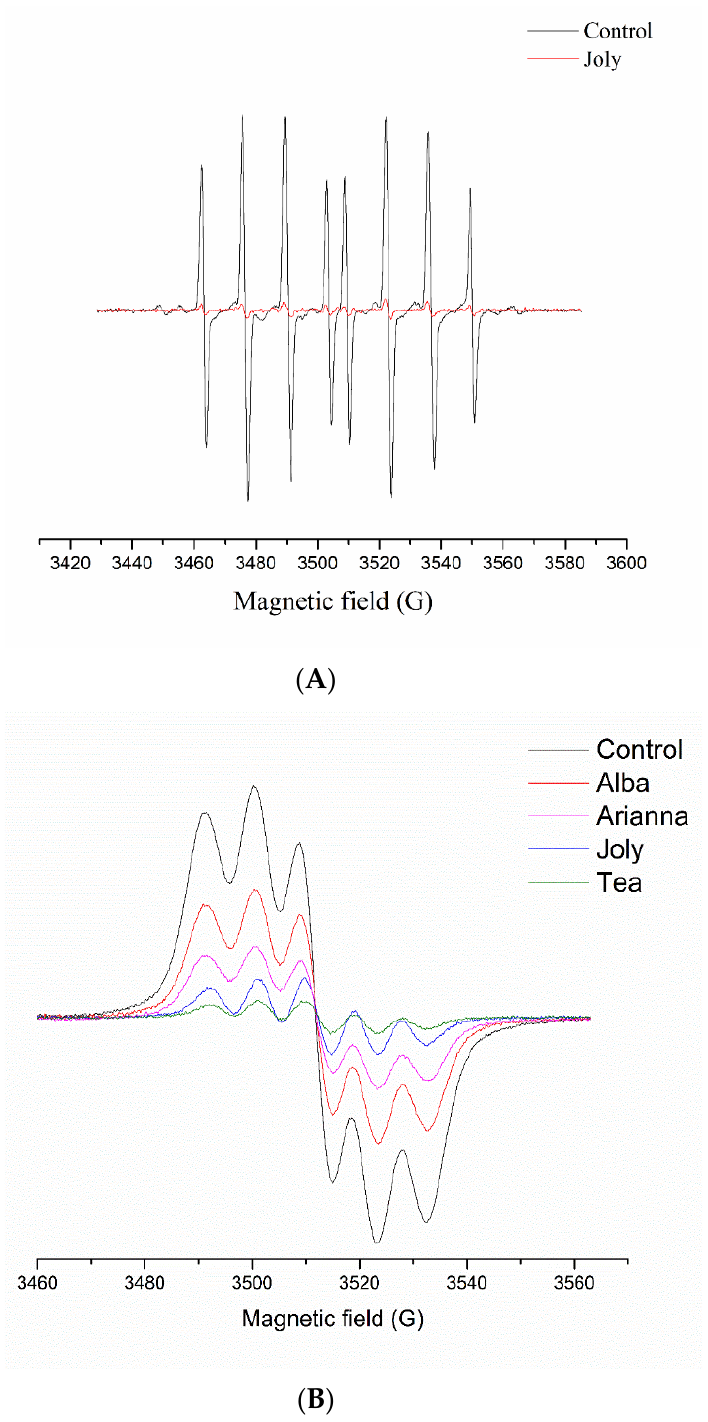
Figure 1. A representative spin-trapping electron paramagnetic resonance (EPR) spectra. EPR spectra of DEPMPO/OH adducts generated by an in vitro Fenton reaction ( A ) and set of individual EPR spectra of DPPH free radicals ( B ).